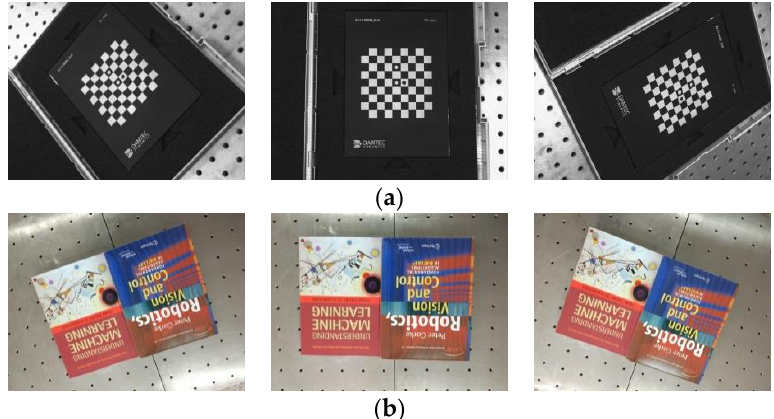
Figure 4. Sample images of calibration scenarios taken by the camera mounted on the gripper of the robot: ( a ) Chessboard pattern scene; ( b ) Books scene.